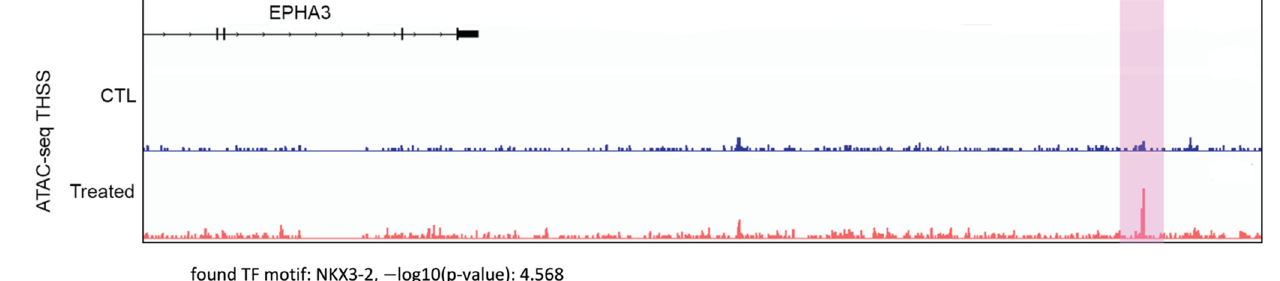
Figure 3. ATAC-seq analysis comparing chromatin accessibility in control mouse tumor tissue (“CTL,” top, in blue) versus Indolium 1-treated mouse tumor tissue (“Treated,” bottom, in red) LM36R cells in the EPHA3 gene. The highlighted region shows a statistically significant ( p -value = 2.7 × 10 − 5 ) difference in chromatin accessibility for the region corresponding to the NKX3-2 binding motif in the EPHA3 gene.